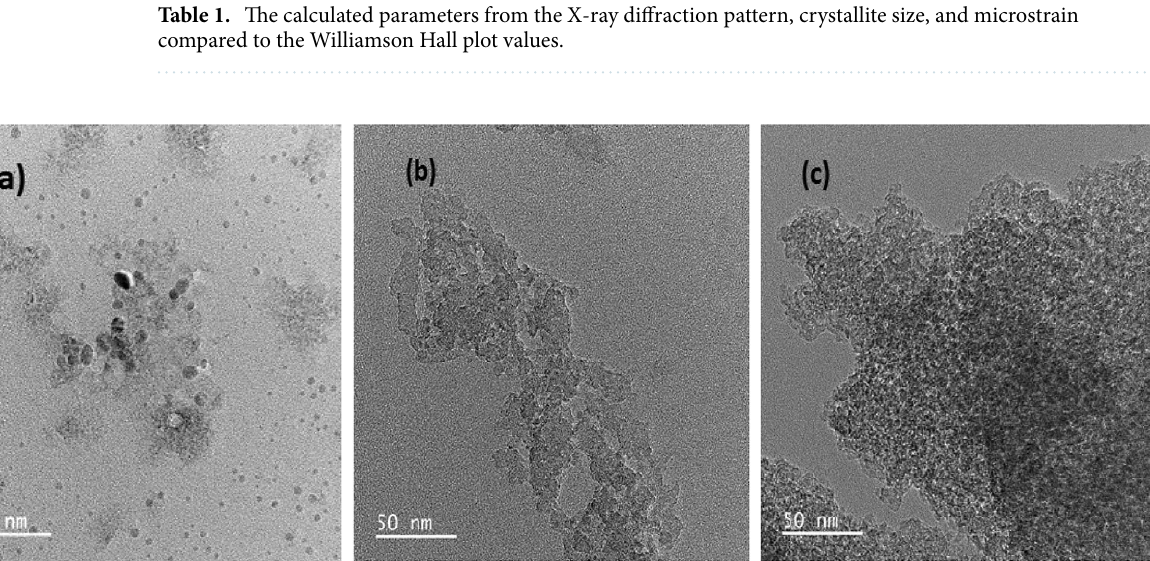
Figure 3. ( a ) Lower magnification TEM image of SMZC nanoceramics doped with ( b ) 0.3, and ( c ) 0.7 Ni 2+ nanoceramics calcined at 800